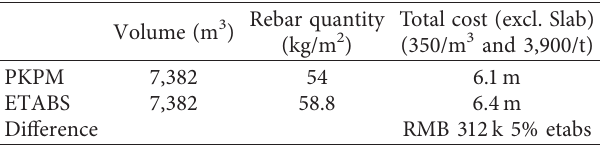
Table 9: Concrete and rebar cost comparison designed by PKPM and ETABS.